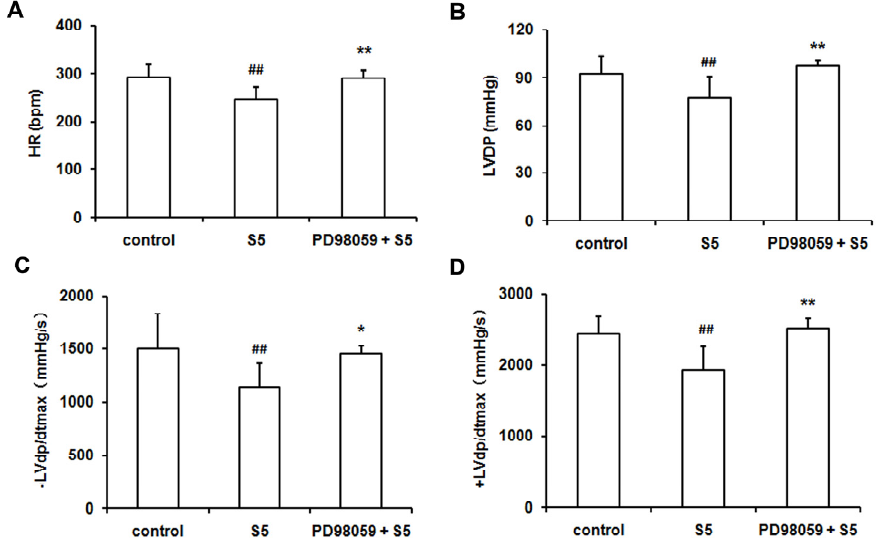
Figure 3. The change in HR ( A ); LVDP ( B ); − LVd p /d t isolated rat heart without ischemia/reperfusion. The 5 μ mol/L SO cardiac function, while PD98059 could prevent the inhibitory effect of the SO ## p < 0.01 versus control group * p < 0.05; ** p < 0.01 versus S5